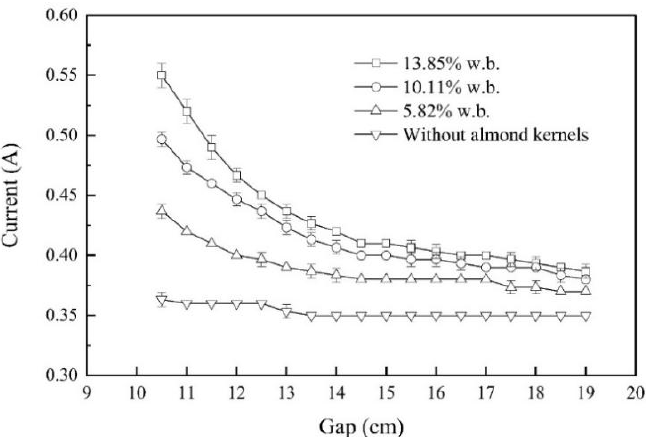
Figure 6. The relationship between electric current and electrode gap for almond kernels with three different a w levels without conveyor belt movement and hot air-assisted heating. different a w levels without conveyor belt movement and hot air-assisted